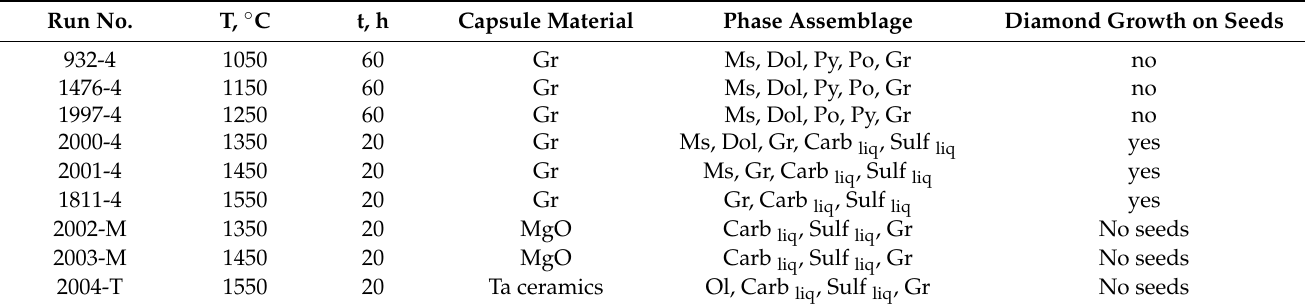
Table 1. Experimental parameters and results obtained in the ankerite–pyrite system (pressure 6.3 GPa). Run No. Capsule Material Phase Assemblage Diamond Growth on